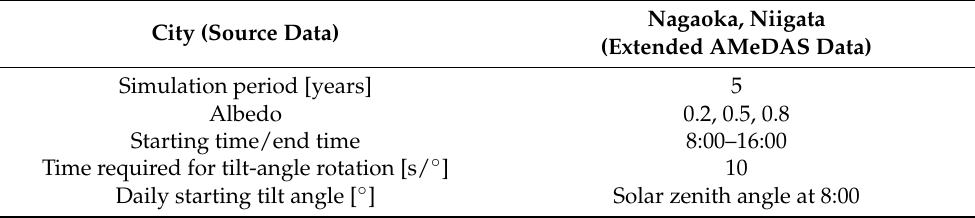
Table 3. Simulation conditions. City (Source